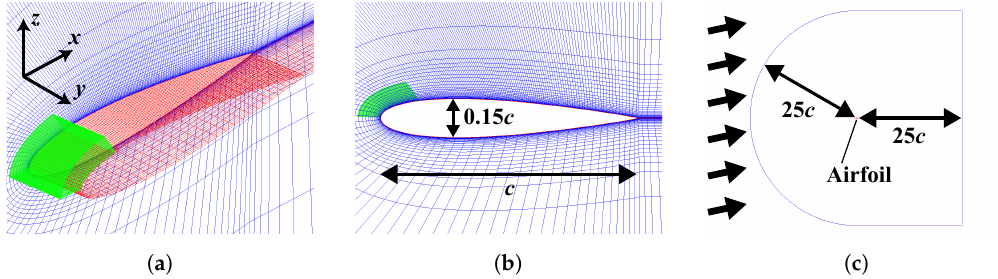
Figure 6. Computational grids and computational domain. The grids were visualized for every four points. ( a ) Perspective view. ( b ) Cross-sectional view. ( c ) Computational domain. Table 1. Number of computational grid points.